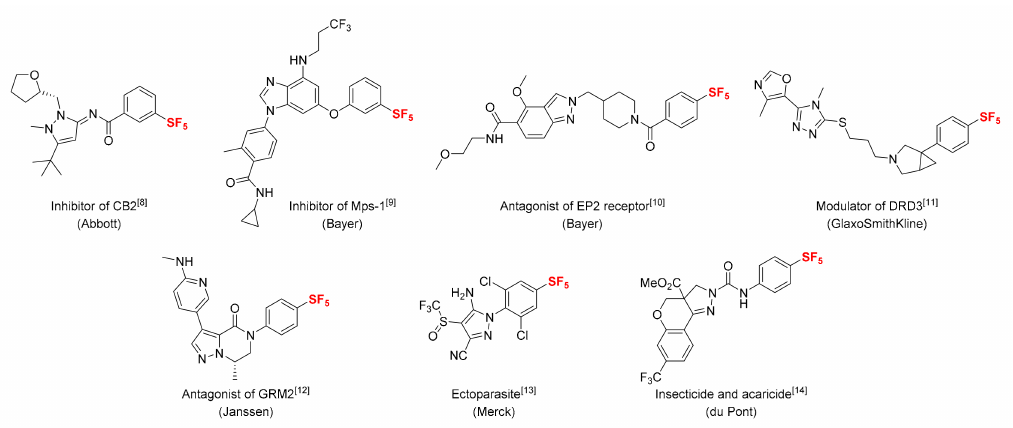
Figure 1. SF 5 -containing biologically active compounds [8–14].